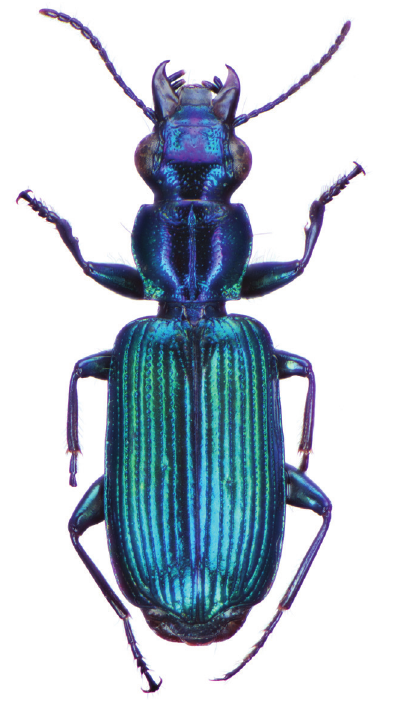
Figure 79. Dorsal habitus and color pattern of Holcoderus formosanus Jedlička. (OBL 8.58